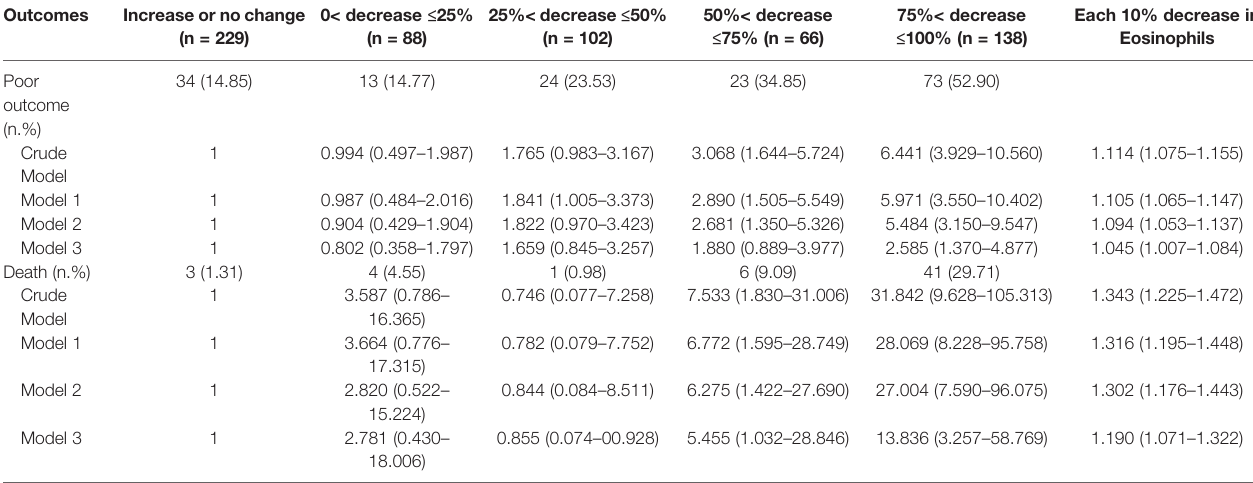
TABLE 2 | Adjusted Odds Ratios of Adverse Outcomes at 3-month According to Eosinophil changes After Intravenous Thrombolysis.